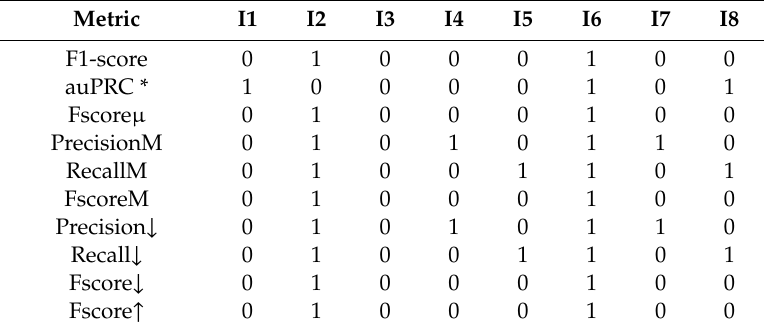
Table 1. Invariance properties of selected metrics. 0 for invariance and 1 for non-invariance. Adapted from